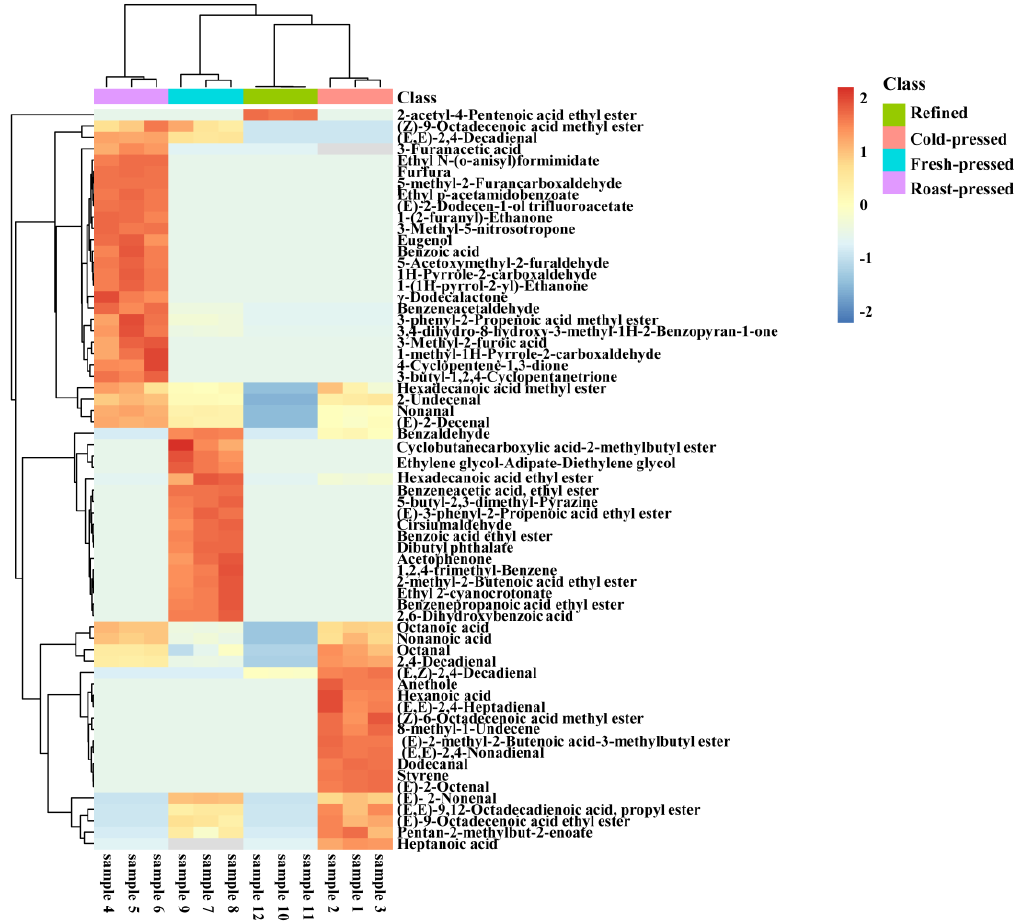
Figure 3. Cluster heat map of volatile compounds of camellia oil by different processing techniques.